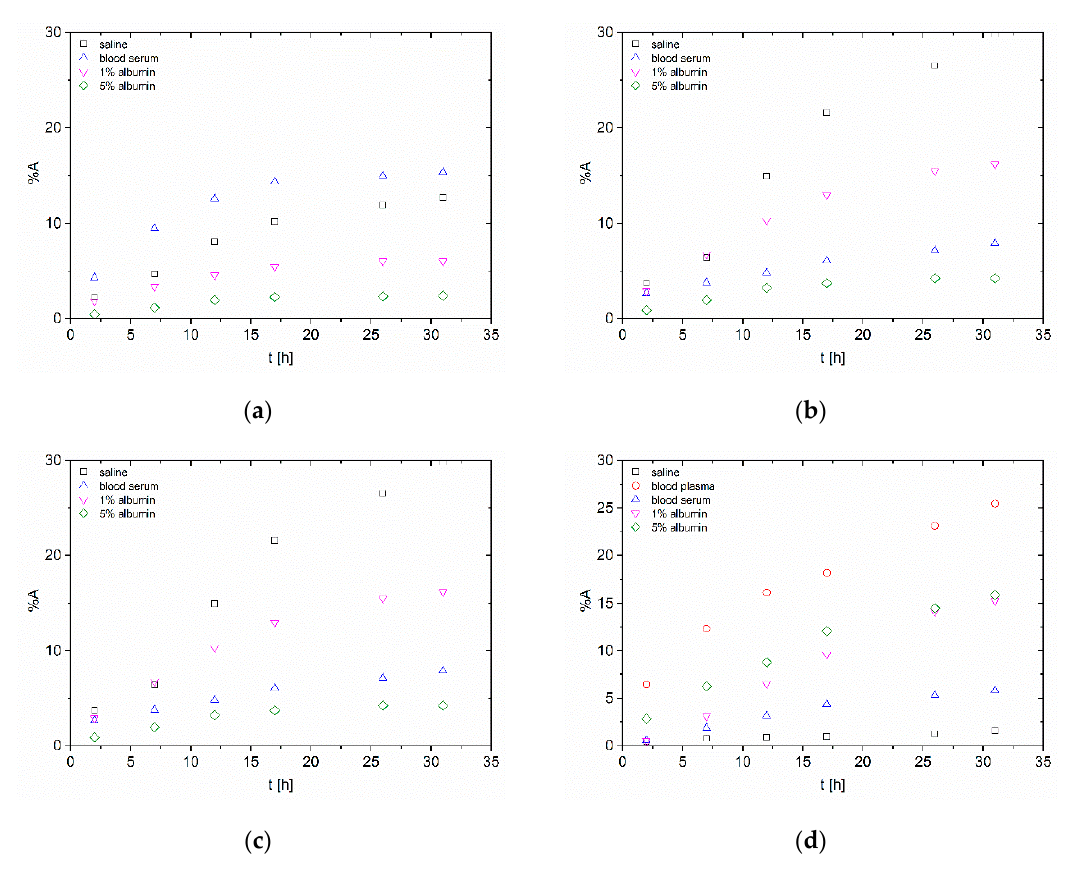
Figure 3. Short-term in vitro stability study of 99m Tc-labelled nanoparticles ( a ) surface radiolabelling of n HAp (except plasma results); ( b ) intrinsic radiolabelling of n HAp (except plasma results); ( c ) surface radiolabelling of n TiO 2 ; ( d ) intrinsic radiolabelling of n TiO 2 .